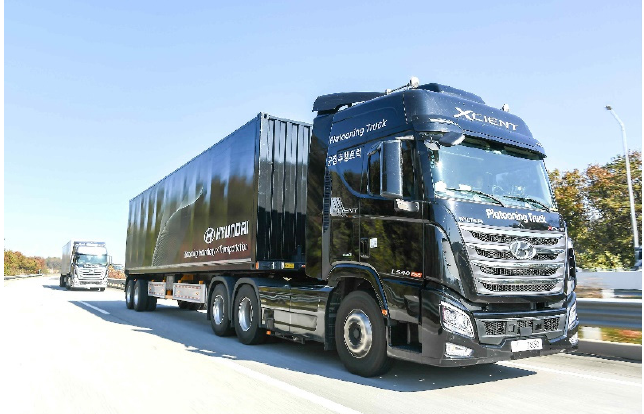
Figure 2. Photo of trucks in the TRuck platOOning Project (TROOP) Project. (Pictured by Hyundai Motor Company).